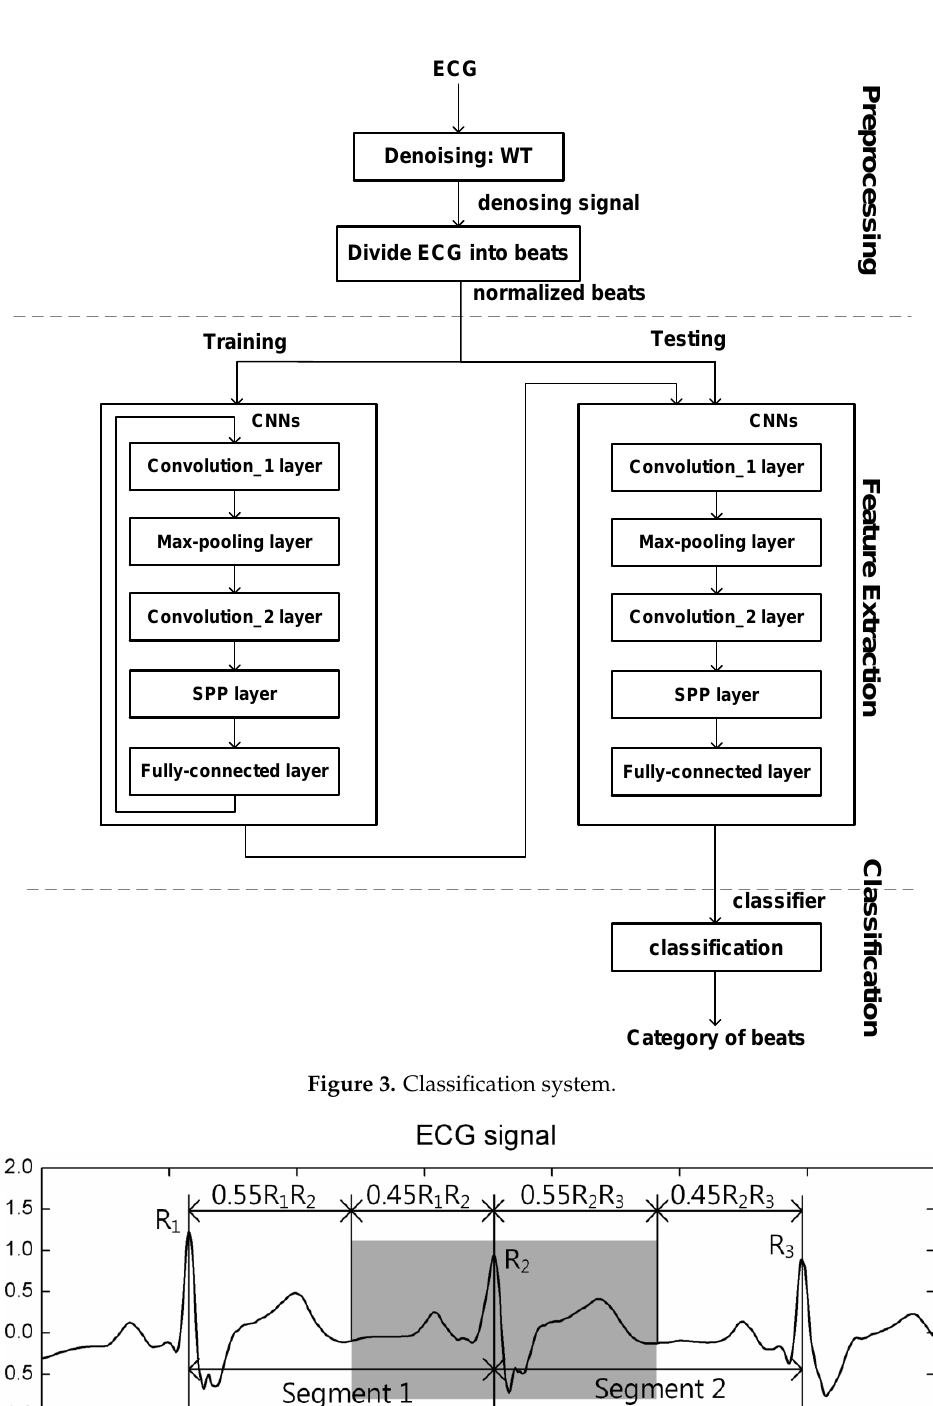
Figure 4. The segmentation of the ECG signal into a heartbeat. Three peaks of the ECG signal are represented as R 1 , R 2 , and R 3 . The peak to peak of the signal was regarded as one segment. The anterior of a segment was connected to the posterior of a segment which emerged earlier. The grey area was a complete heartbeat signal.